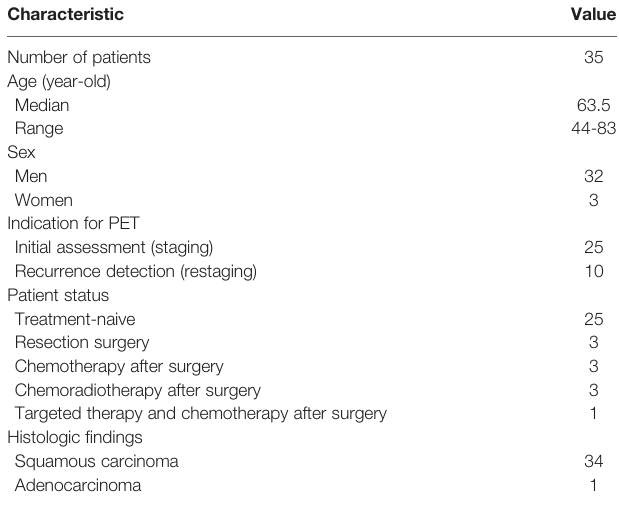
TABLE 1 | Summary of Patient